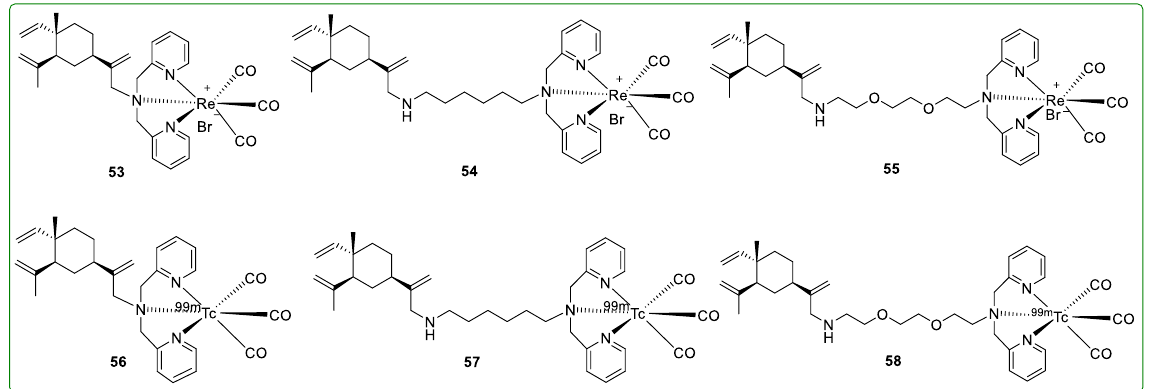
Figure 19. Chemical structures of radioactive derivatives 53 – 58